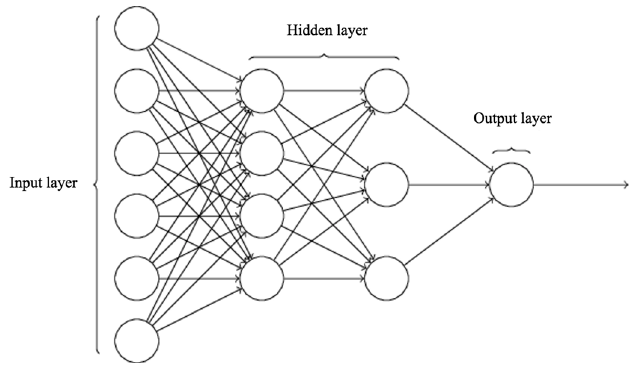
Figure 3. Multi-layer perceptron ( MLP) model structure.